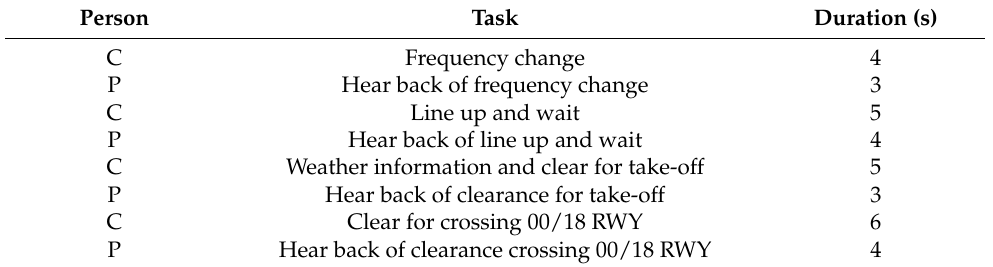
Table 5. Departure tasks of R-YATC.